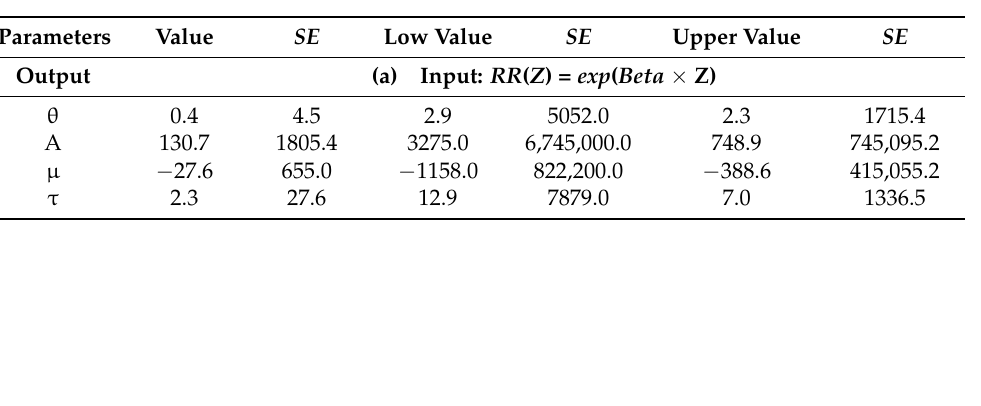
Table 2. Estimations based on the RR values calculated for lag from 0 to 8. Three forms of the input ( a )–( c ) are realized. ED visits for all respiratory conditions. Edmonton, Canada,